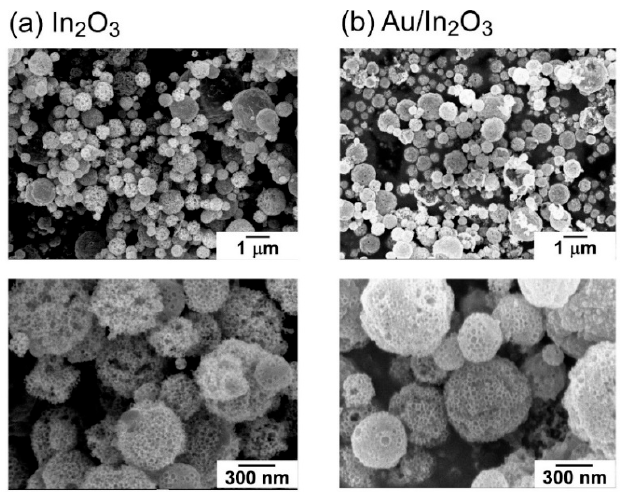
Figure 2. SEM photographs of ( a ) In 2 O 3 and ( b ) Au/In 2 O 3 powders.